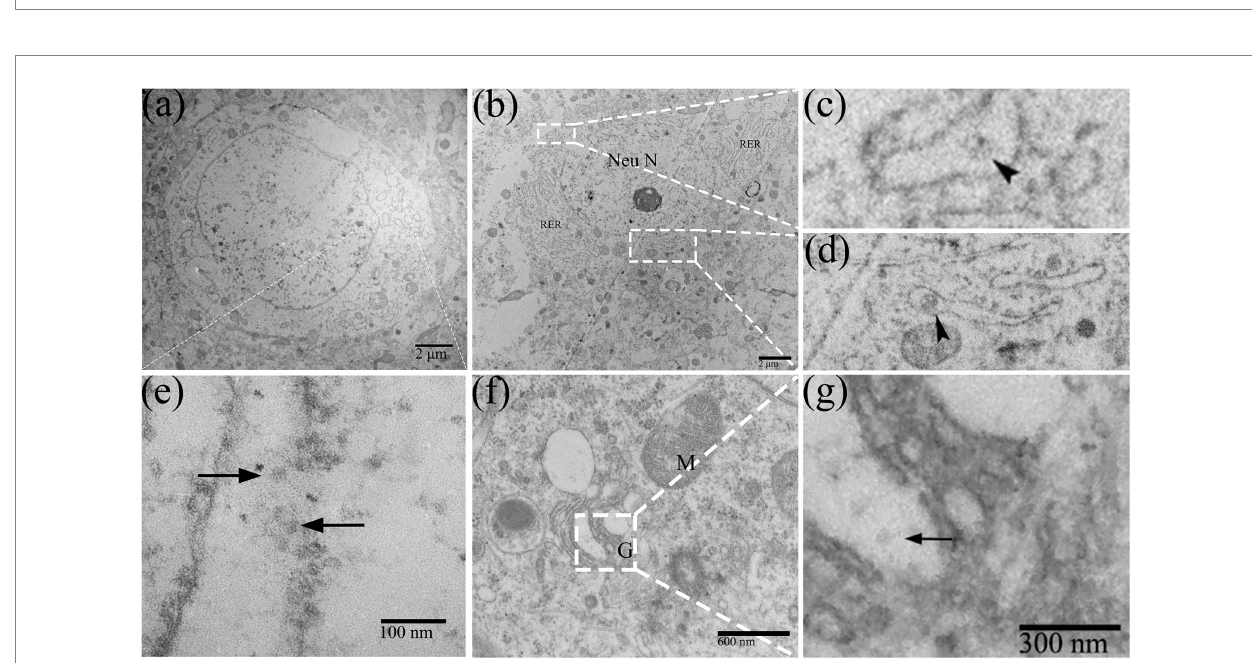
FIGURE 3 The replication process of DTMUV in neurons in duckling brain. (A,E) Dilated RER cisternae contained multiple virions (arrow). (B–D) RER cisternae contained membranous vesicles (arrowhead). (F) Golgi apparatus showed markedly vacuolar change. (G) The Golgi apparatus contains virions (arrow) within its saccules. RER, rough endoplasmic reticulum; M, mitochondrion; G, golgi apparatus; and Neu N, neuron